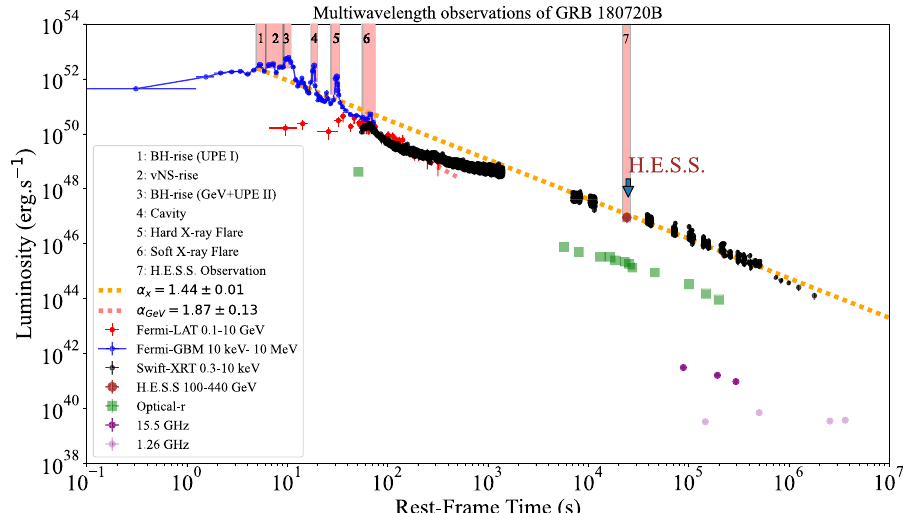
Fig. 1 Luminosity of GRB 180720B in the cosmological rest-frame of the source. Blue circles: obtained from Fermi -GBM in the 10 keV– 10 MeV energy band. Red circles: obtained from Fermi -LAT in the 0 . 1–10 GeV energy band. The Episode 1 shows the BH–rise (UPE I) from t rf = 4 . 84 s to t rf = 6 . 05 s. The Episode 2 shows the ν NS– rise from t rf = 6 . 05 s to t rf = 9 . 07 s. The Episode 3 represents the second UPE phase (UPE II) from t rf = 9 . 07 s to t rf = 10 . 89 s. The Episode 4 shows the Fermi-GBM the cavity from t rf = 16 . 94 s